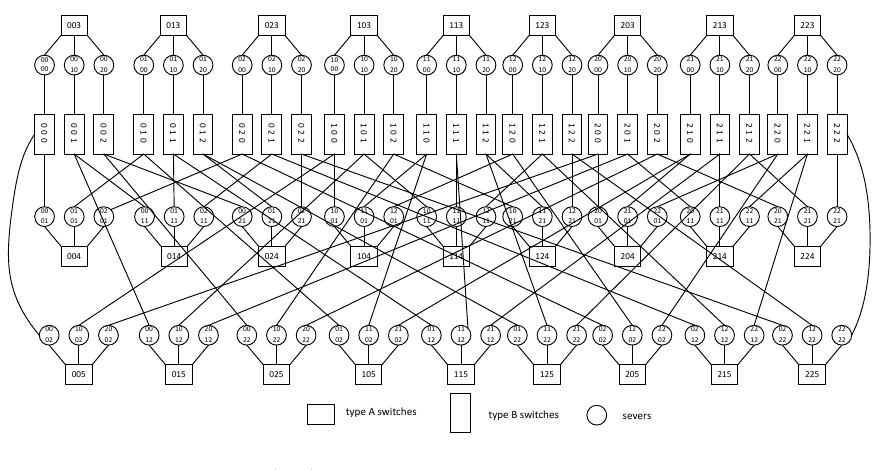
Figure 1. Structure of BCCC ( 3,2 )